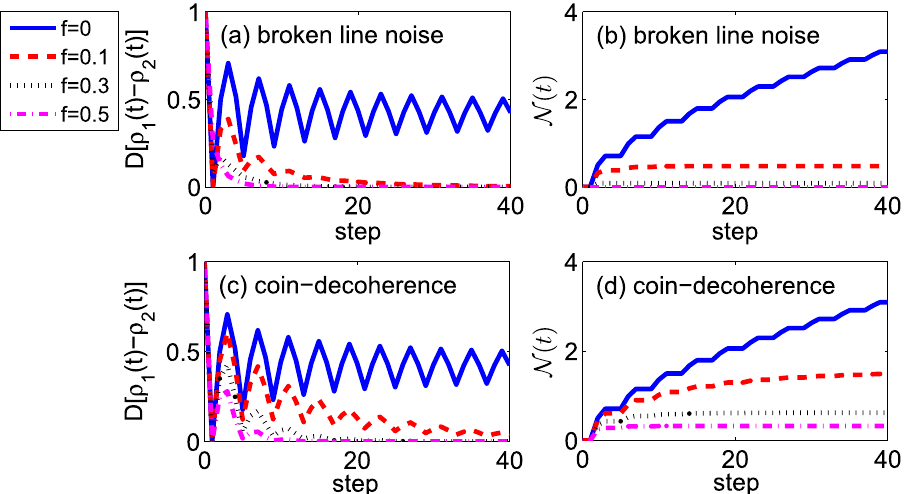
Figure 2. The one dimensional QW with different strengths of decoherence. Blue solid, f = 0; Red dashed, f = 0.1; Black dotted, f = 0.3; Magenta dotted dashed, f = 0.5. ( a , b ) The broken line noise is considered in the walk. ( a ) The step evolution of the trace distance between the coin states ρ 1 ( t ) and ρ 2 ( t ). The initial coin states are chosen as ρ = R R (0) and ρ = L L (0) . ( b ) The non-Markovianity t ( ) of the coin with the step 1 2 evolution in the walk. ( c , d ) The coin-decoherence is introduced into the walk. ( c ) The trace distance between the coin states ρ 1 ( t ) and ρ 2 ( t ). The initial coin states are chosen as ρ = R R (0) and ρ = L L (0) . ( d ) The 1 2 non-Markovianity of the coin with the step evolution in the walk.